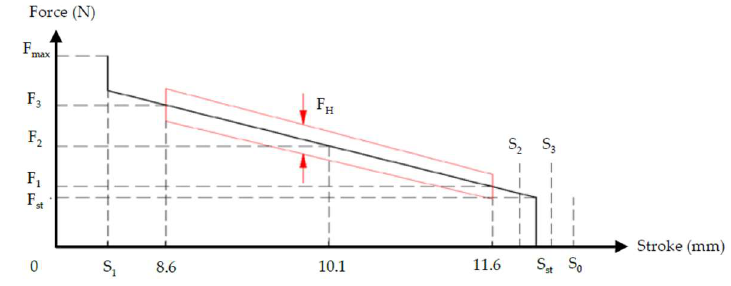
Figure 4. Stroke and force Curve.